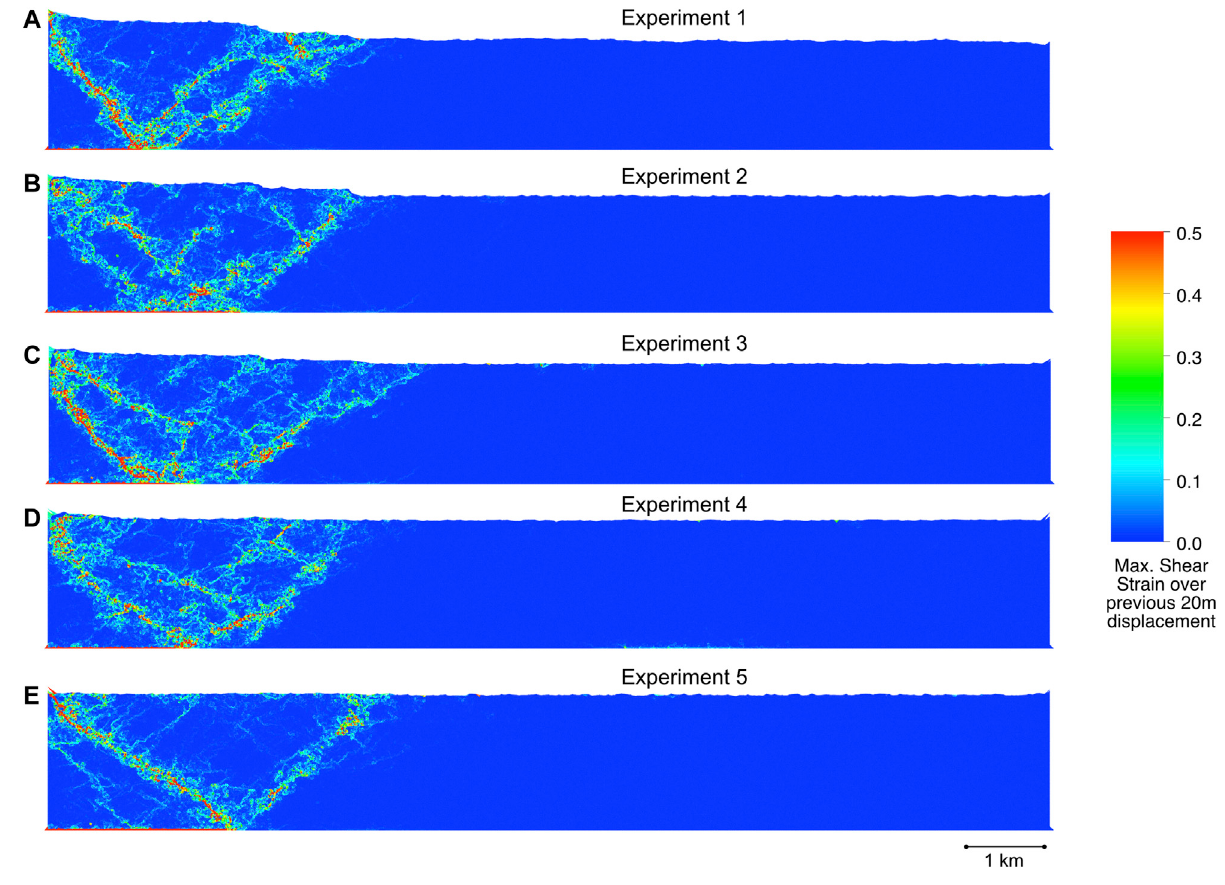
Frontiers in Earth Science |